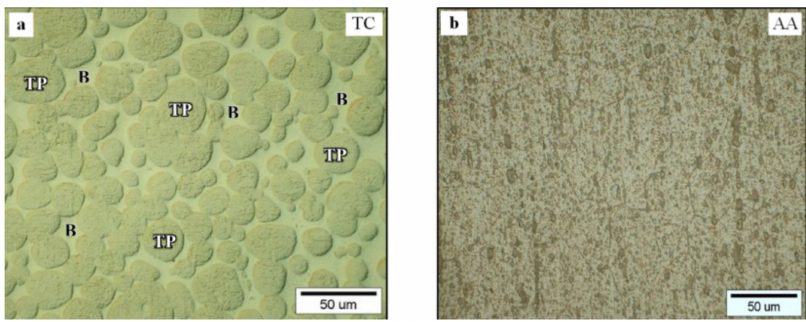
Figure 1. Microstructures of base materials: ( a ) tungsten composite, ( b ) aluminum alloy.